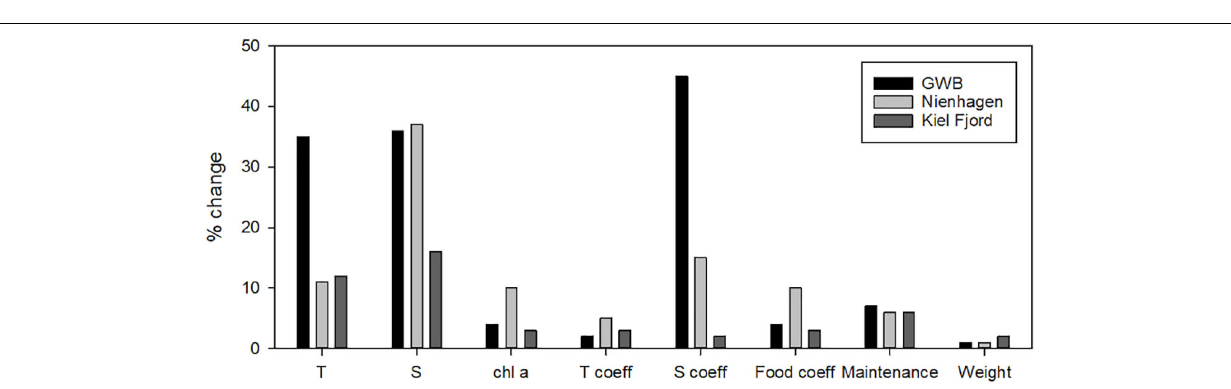
FIGURE 3 | Model sensitivity study showing the change (%) in mussel tissue to ± 10% changes in temperature (T), salinity (S), chl- a concentrations, the Arrhenius temperature coefficient (T coeff), the salinity maintenance cost coefficient (S coeff), the half-saturation food coefficient (Food coeff), the somatic maintenance cost coefficient and the initial weight of mussel